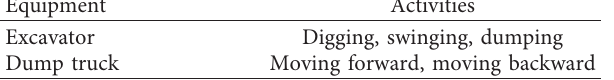
Table 1: Construction equipment activities.